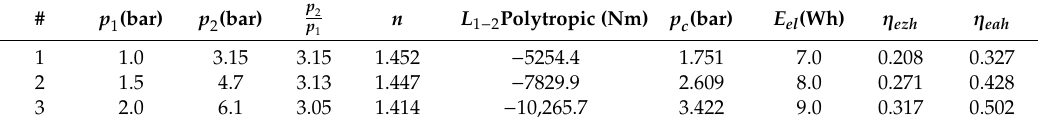
Table 1. Summary of the test results for a displacement pump subsystem and a hydrophore